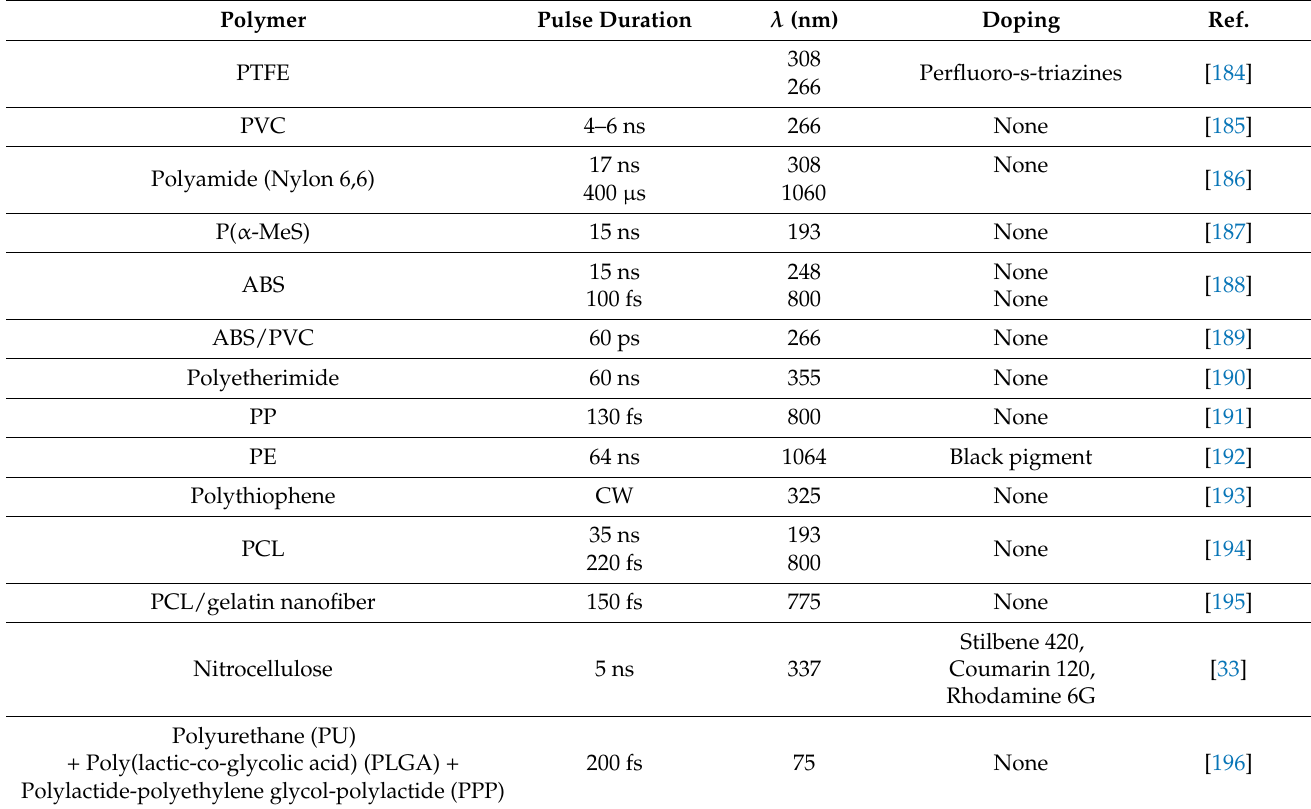
Table 7. Evidence of successful laser ablation of common polymers. Polymer Pulse